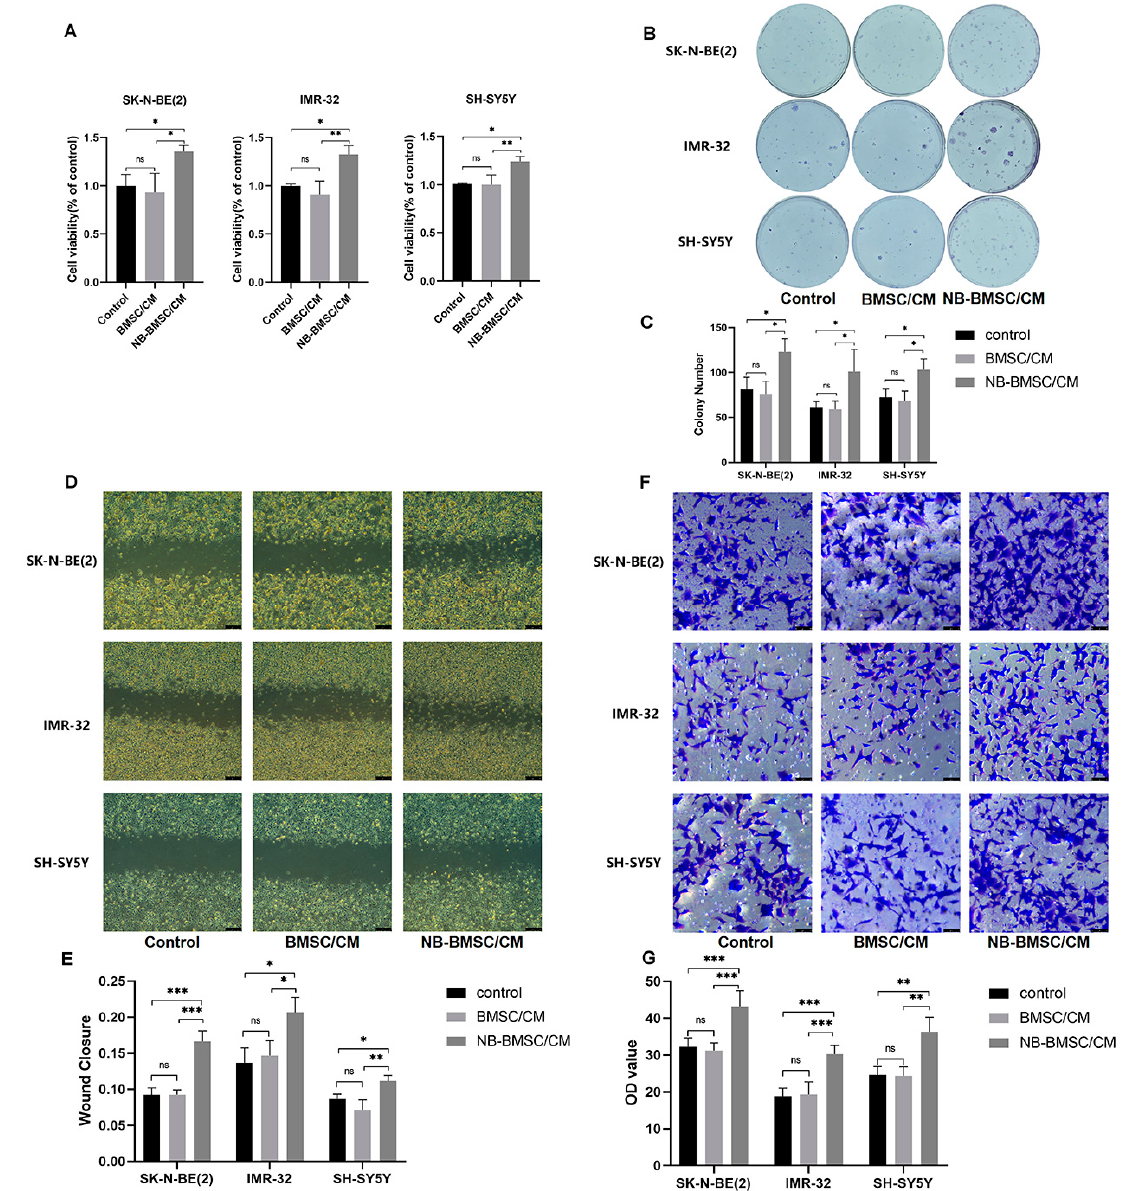
Figure 1. NB-BMSCs promoted NB growth and migration. ( A ) CCK8 assay was performed to assess